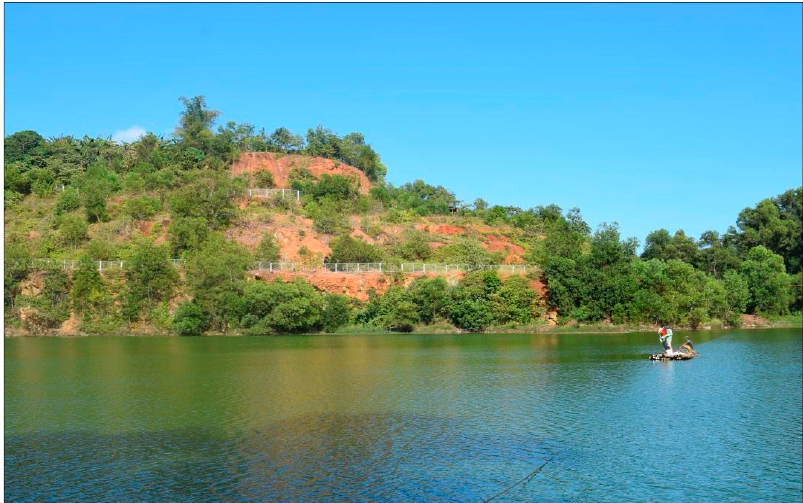
Figure 2. Photo of mine waste calcines stockpiled at the shore of the pit lake.